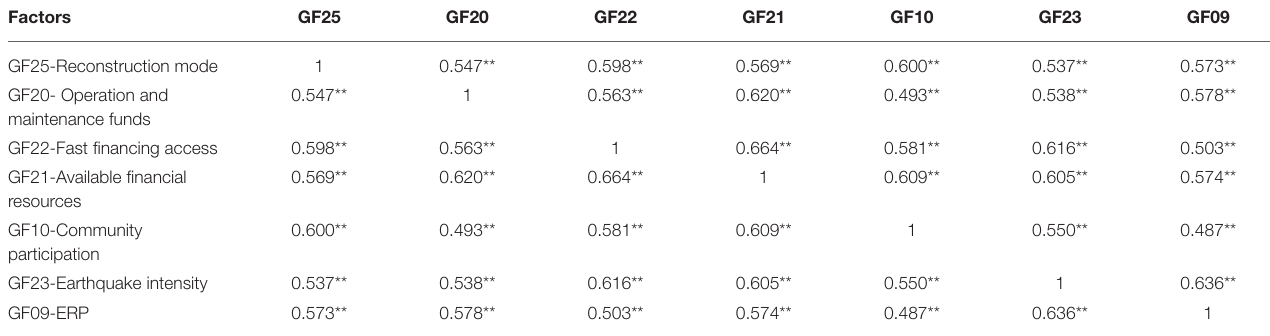
TABLE 7 | The Pearson correlations among factors in G1.